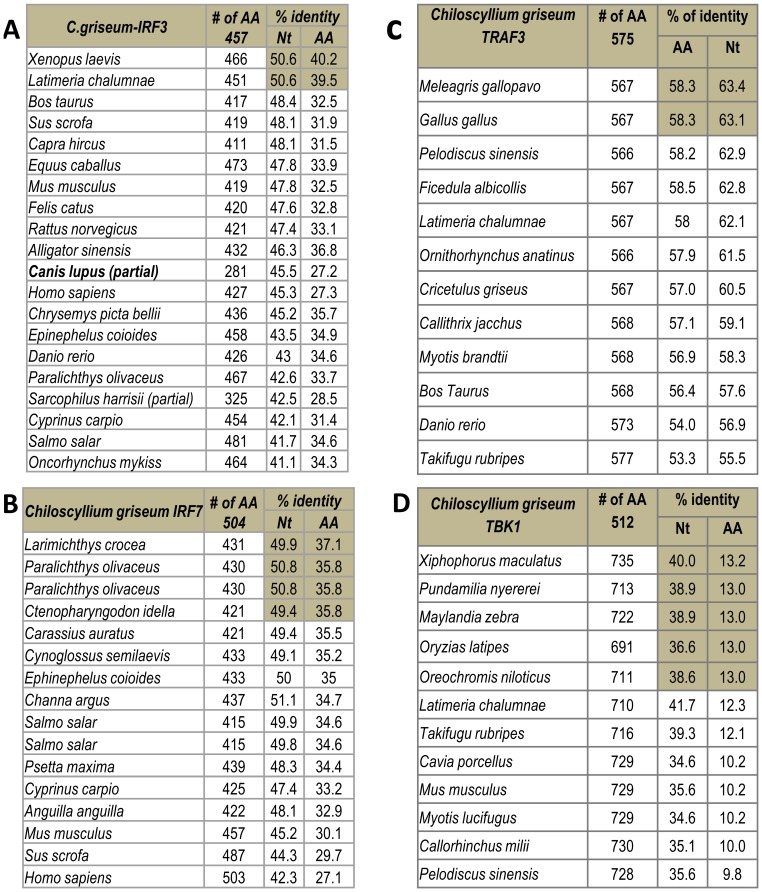
Percentage of nucleotide and amino acid identity of the Chiloscyllium griseum Toll-like receptor 3 (shTLR3) signaling pathway mediators with sequences of other species.The full-length coding sequence of the C. griseum TRAF3 (1728 bp), TBK1 (1529 bp), IRF3 (1374 bp), IRF7 (1515 bp) and Mx (partial 353 bp) sequences was aligned with the other sequences representing these signaling molecules types from different lower and higher order species using Clustal W in the Megalign Module of Lasergene (V 7.1.0). Note
: These signaling molecules revealed extreme diversity and the identity revealed close relationship with the higher vertebrate TLRs rather than the teleost. The TBK1 molecule was divergent among the signaling mediators.